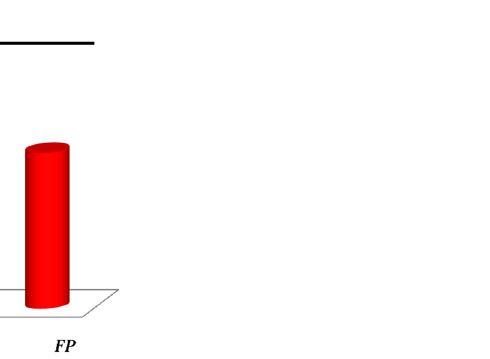
Figure 7. Percent tiller damage caused by Bandicoot rats, Bandicota bengalensis under diverse tillage and production system. Arrow distance indicates significant differences among production systems (LSD; P <